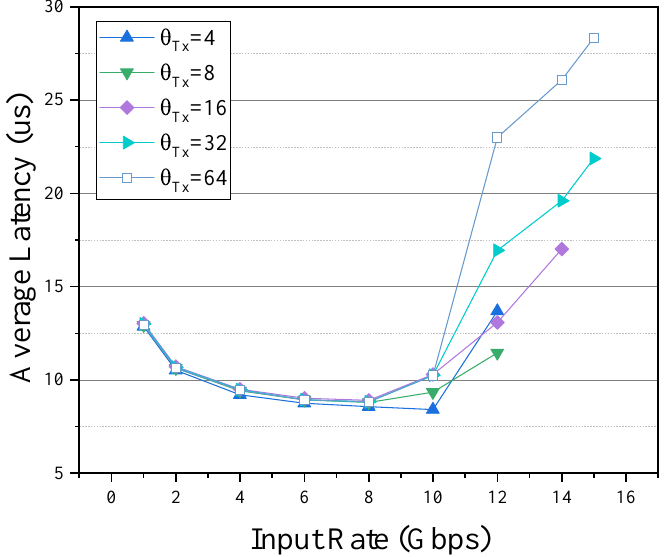
Figure 5. The average latency under different input rates and different θ Tx